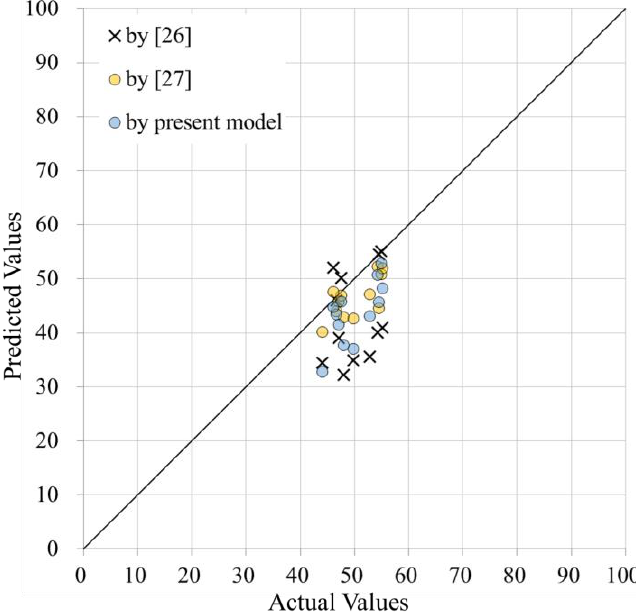
Figure 3. Comparison of the predicted values with the actual 28-day compressive strength of concrete [26] (Unit: MPa).